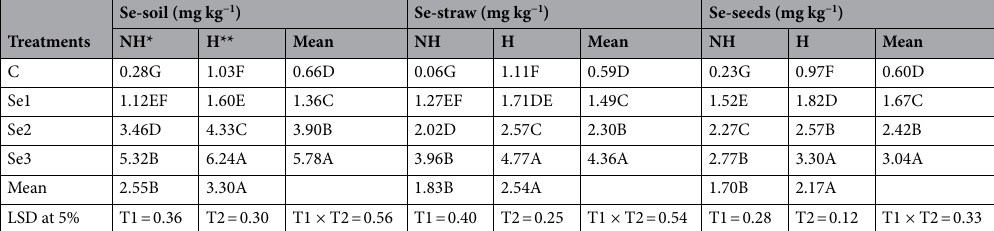
Table 7. Effects of Se and K-humate applications on Se content. *Refers to Se application without K-humate. **Refers to the simultaneous application of Se and K-humate.